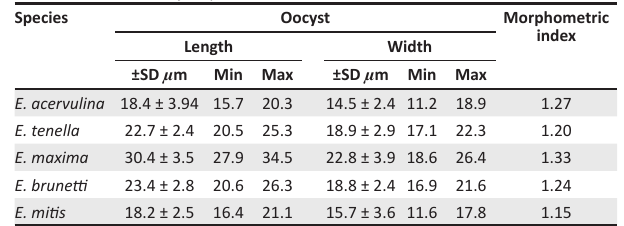
FIGURE 3: Prevalence of coccidiosis by age groups.